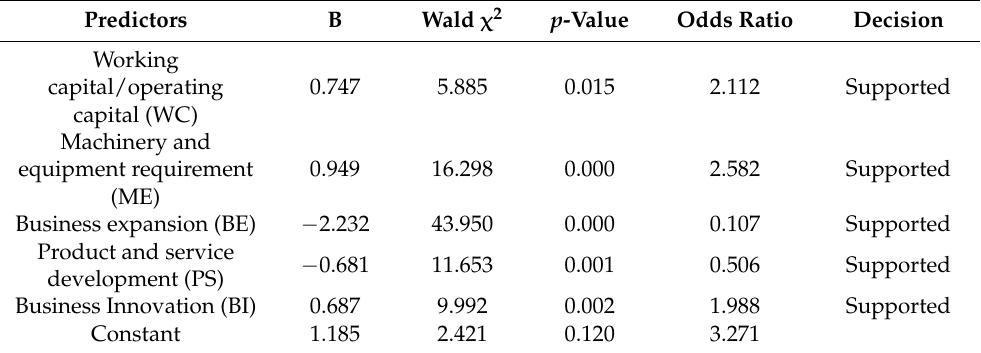
Table 6. Logistic regression of effects of motivation on the choice of sources of small and medium- sized enterprise (SME)